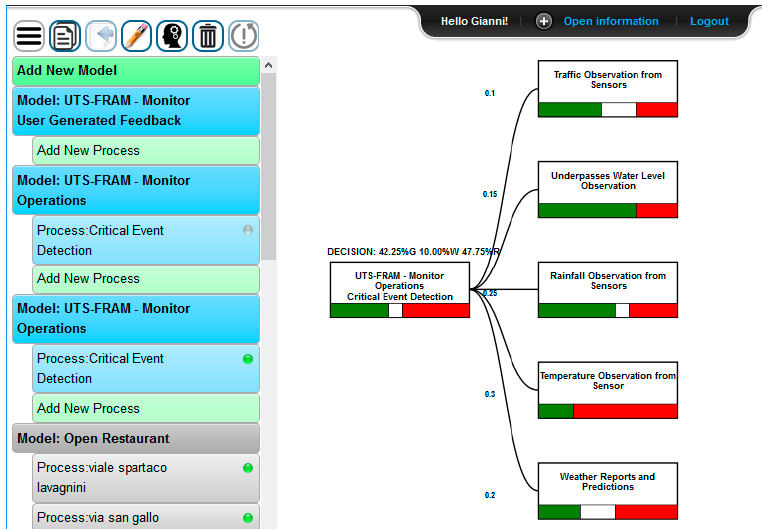
Figure 19. SmartDS decisional process implementation as to the Monitor Operations function (represented in the FRAM sub-set in Figure 16).